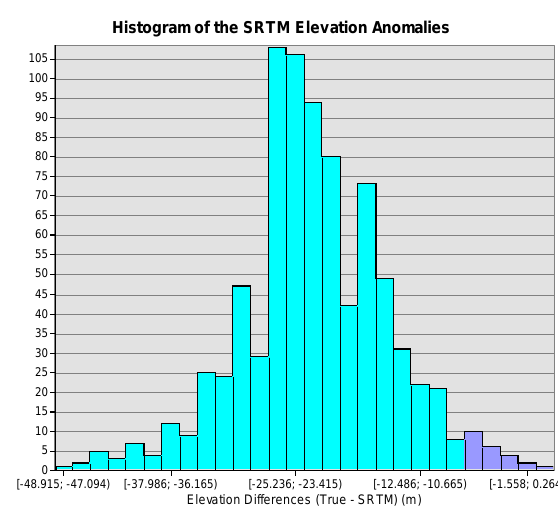
Figure 2. Histogram of the SRTM elevation for the Atlanta International Airport. The elevation anomalies are represented by lighter bars. A range of ‗correct‘ elevations is represented by darker bars. There were two data takes for this